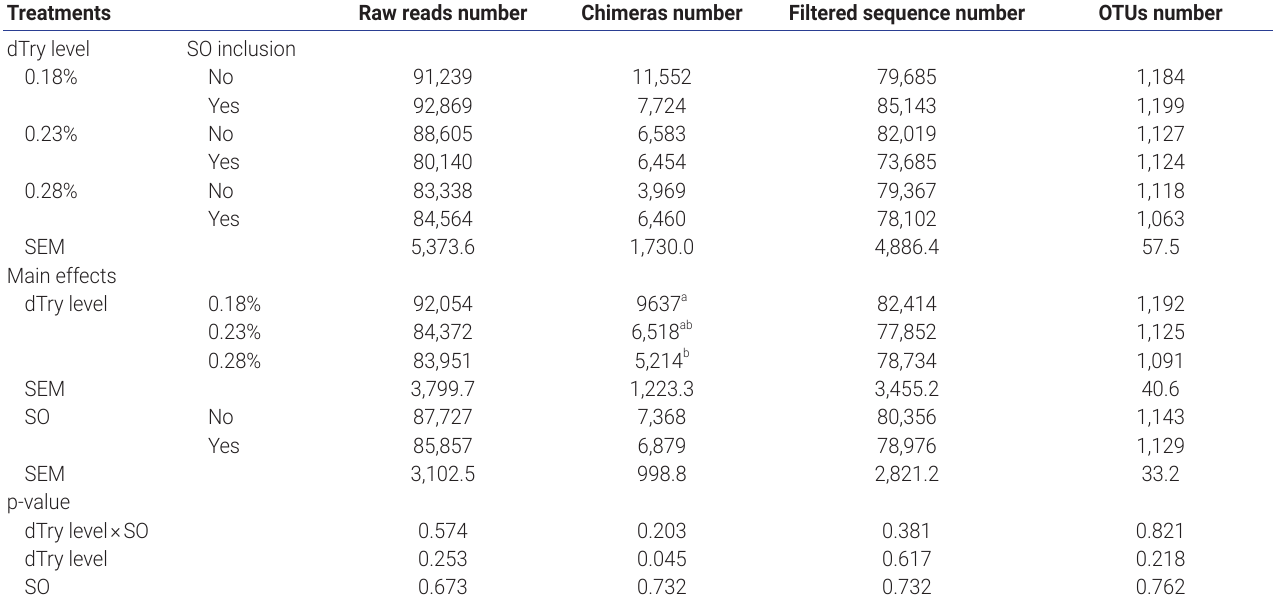
Table 4. Effects of dietary digestible tryptophan and soy oligossacharide supplementation on microflora DNA sequence data in caecal contents of broiler chickens Treatments